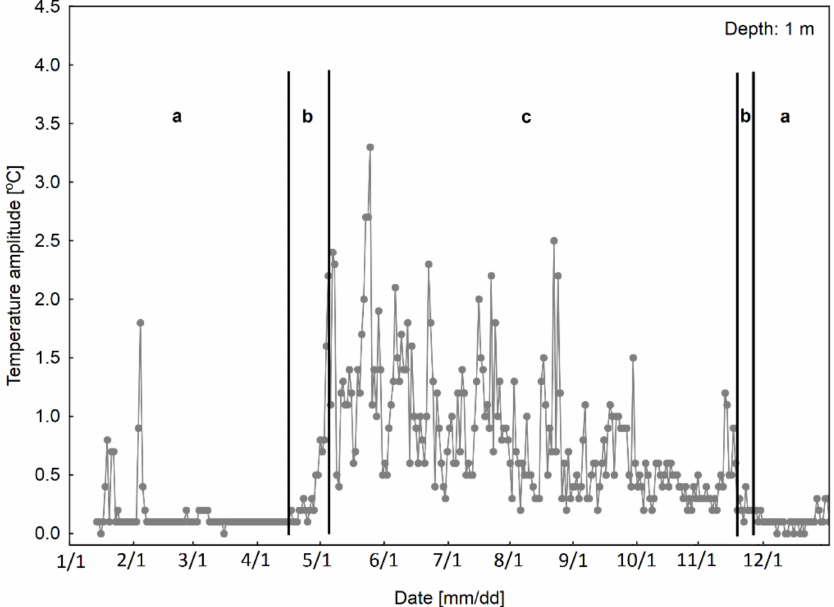
Figure 1. Changes in water temperature amplitudes in time at a depth of 1 m. a—presence of ice cover; b—occurrence of ice phenomena; c—lack of ice cover/ice phenomena.